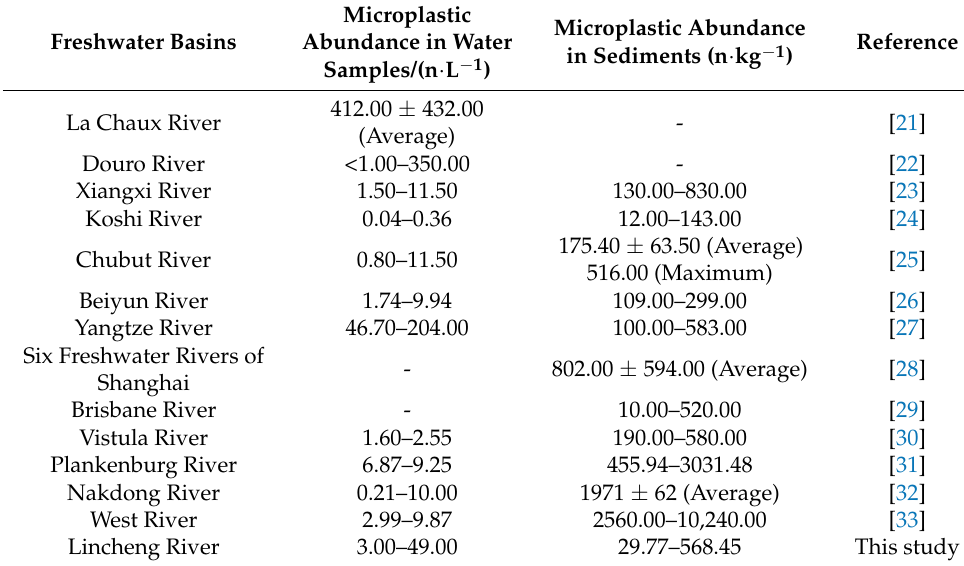
Table 1. Microplastic abundance in some typical freshwater